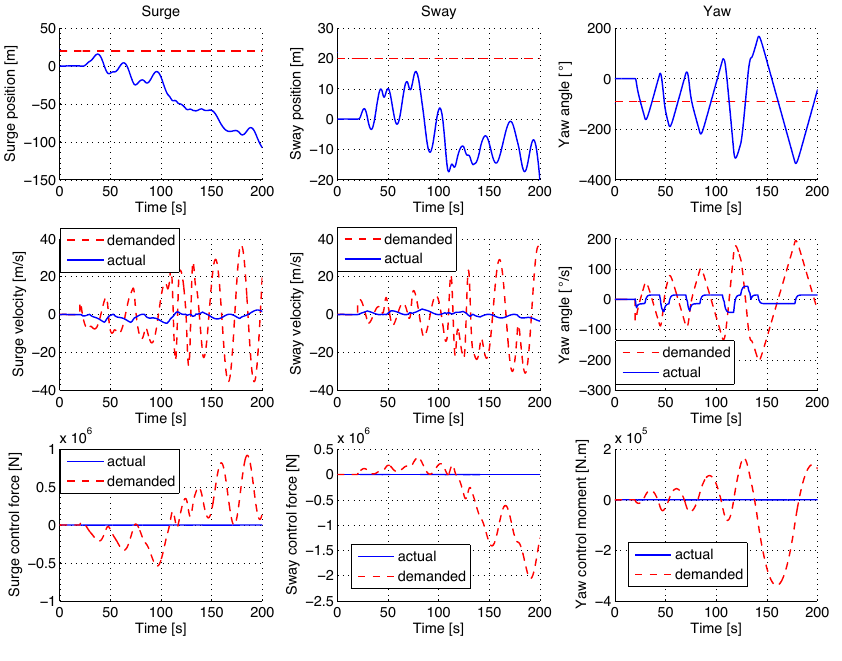
Figure 13: Performance of vehicle position regulation controller in current and position set point change under an actuator fault, for the case where the anti-windup is not active.